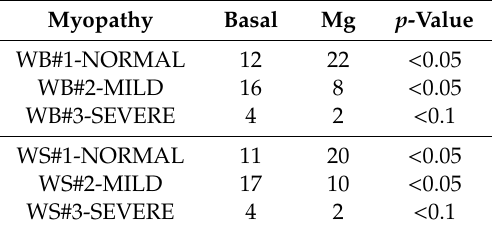
Table 6. E ff ect of the dietary treatment on the incidence (number of animals with a given severity assessment) of wooden breast (WB) and white striping (WS) upon slaughter. Myopathy Basal Mg p -Value WB#1-NORMAL 12 22 < 0.05 WB#2-MILD 16 8 < 0.05 WB#3-SEVERE 4 2 < 0.1 WS#1-NORMAL 11 20 < 0.05 WS#2-MILD 17 10 < 0.05 WS#3-SEVERE 4 2 <